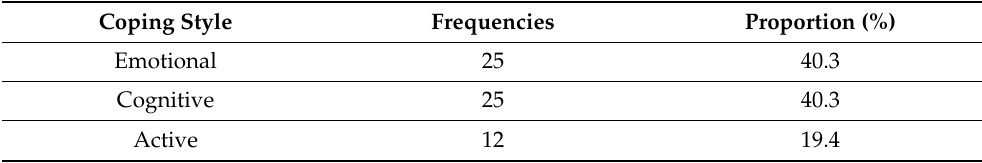
Table 2. Frequencies and proportions of the RDI categories by continuum.